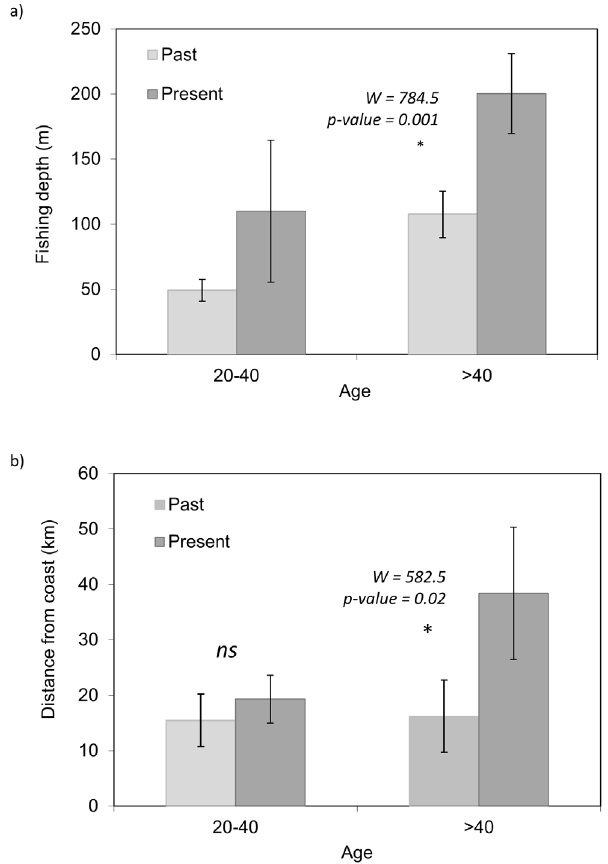
Figure 5. Mean and standard deviation of a) depth (m) and d) distance from the coast (km) between past and present fishing activities by age group (fishers younger or older than 40 years